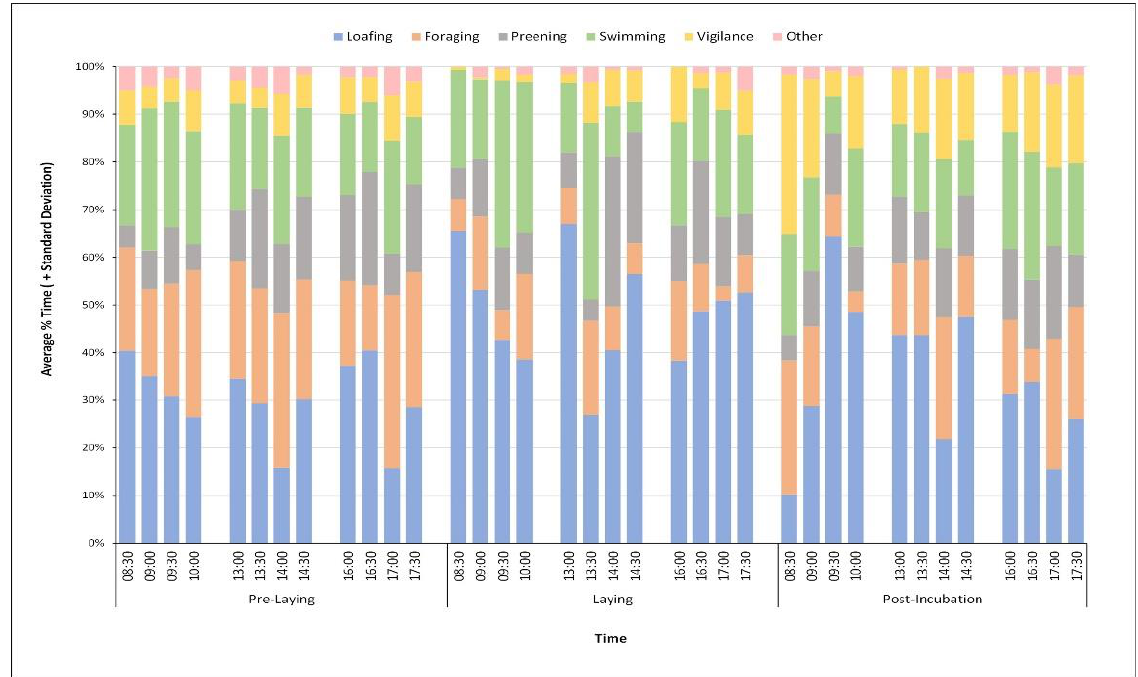
Figure 5. Average percentage time budget of the Mandarin during different social periods. Averages with standard deviations are tabulated in the supplementary information (Table S1).